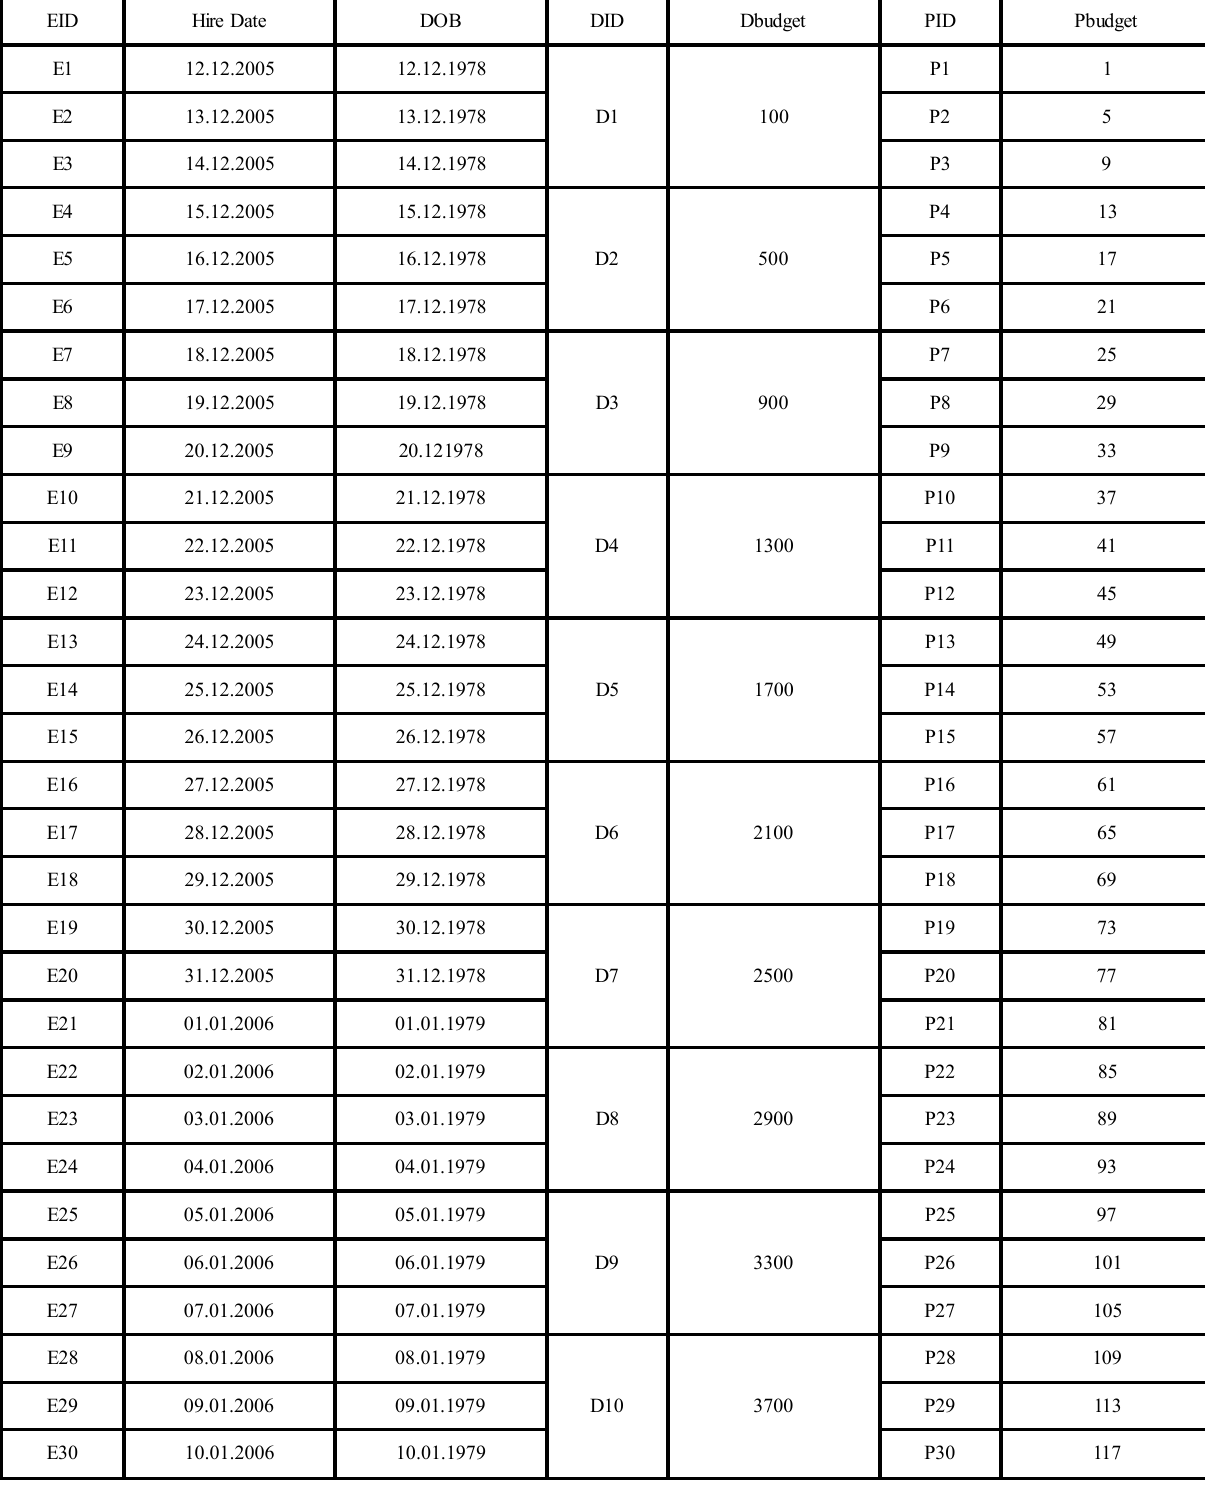
TABLE 8. VALID PROPERTIES SETTING FOR COMPNAY